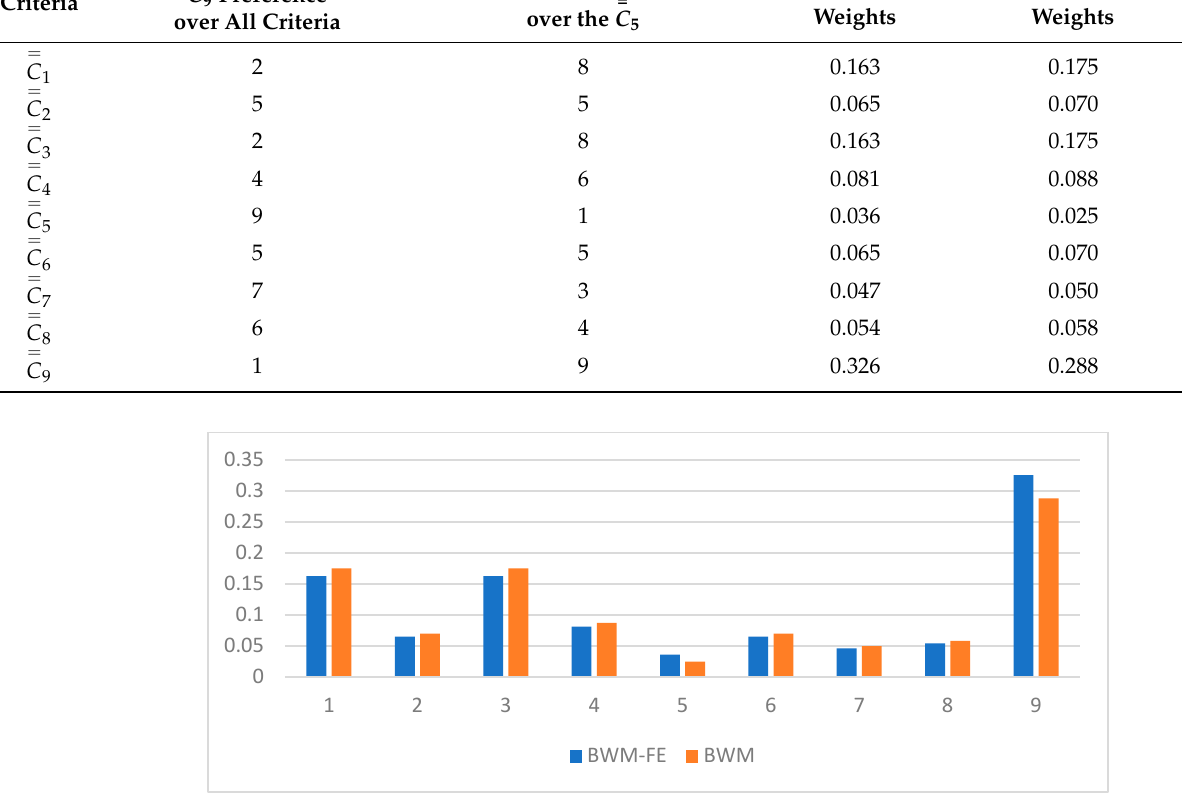
Table 7. The evaluation matrix T. SMD